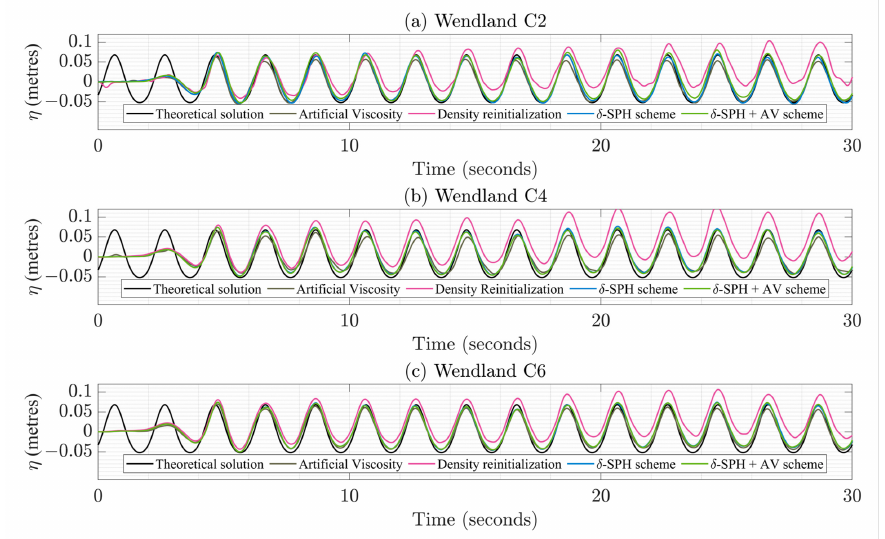
Figure 13. Comparison of the wave surface elevation at x = 6 m for the different dissipation schemes for the three Wendland kernels with the theoretical second-order Stoke’s solution.